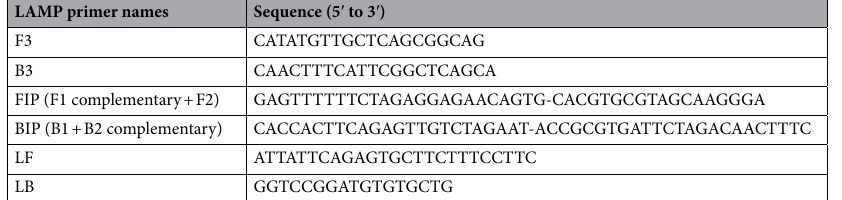
Table 2. Sequence information of newly designed TR46-LAMP primer sets in the present experiment.